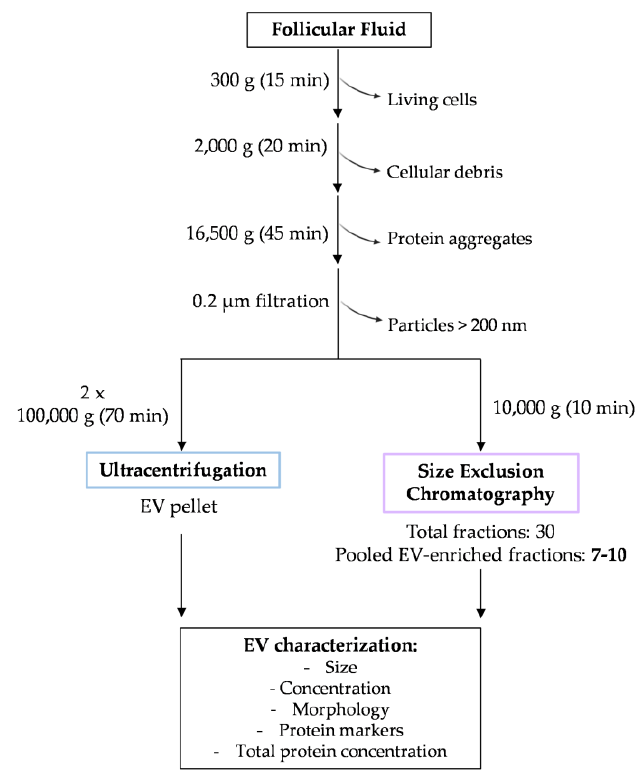
Figure 1. Schematic representation of the experimental design. FF samples were centrifuged at 300 × g and 2000 × g to exclude living cells and cellular debris, respectively. The supernatant was centrifuged at 16,500 × g to pellet protein aggregates. A 0.2 µ m filtration step was conducted to remove particles larger than 200 nm. From this volume, 1 mL was stored at − 80 ◦ C for EV isolation using SEC, and the remaining volume was ultracentrifuged twice to isolate the final UC EV pellet. In total, 30 fractions of 500 µ L were collected, and EV-enriched fractions (F7–10) were used for further characterization. The EVs isolated using UC and SEC F7–10 fractions were characterized regarding the particle size, concentration, morphology, presence of specific markers, and the total protein content using DLS, NTA, TEM, Western blot, and microBCA, respectively.